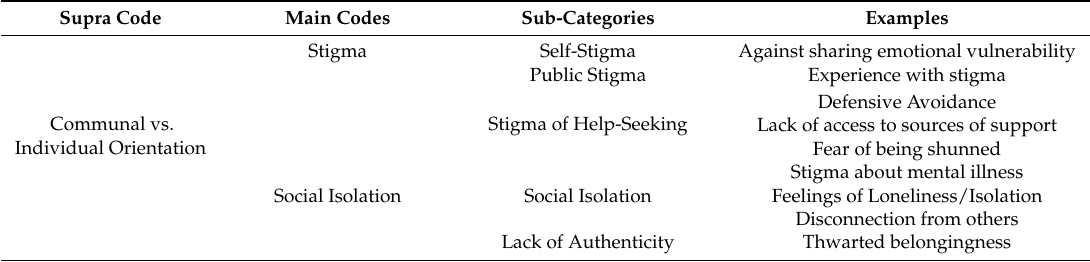
Table A1. A Priori Coding Categories, Sub-Categories and Descriptive